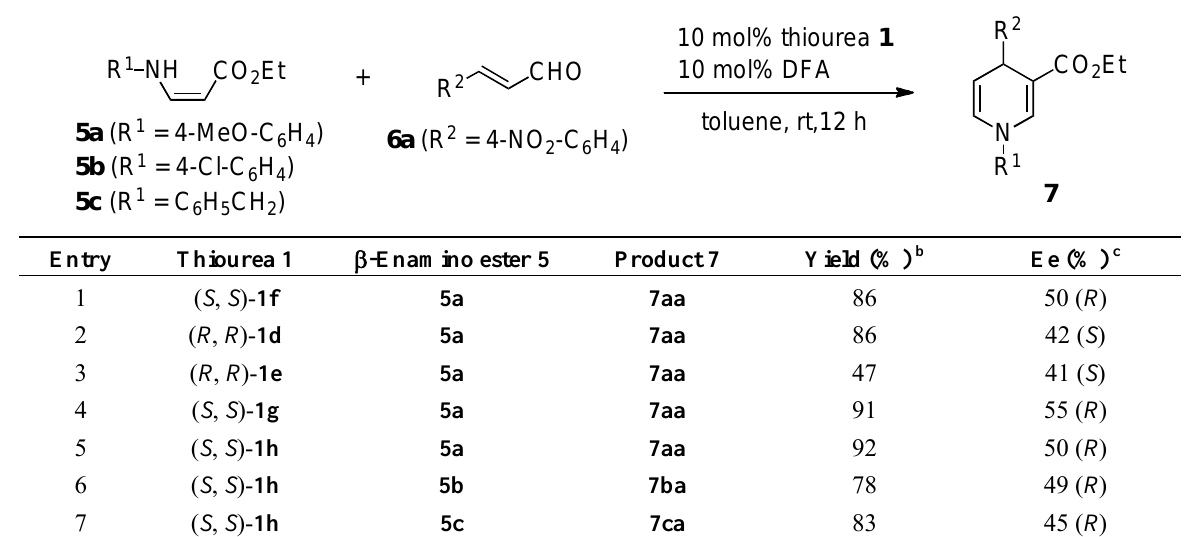
Table 3. Effect of N -arylaminothioureas in the presence of DFA for the synthesis of 1,4-DHP's. a